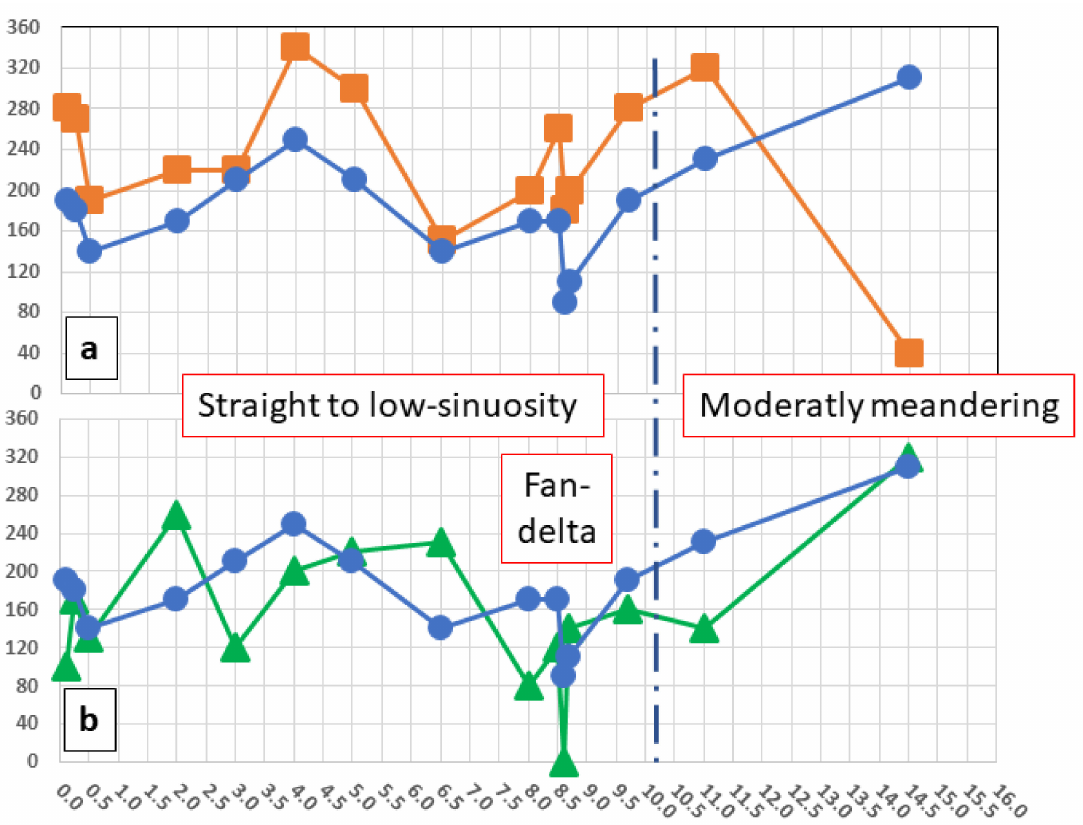
Figure 17. Situmetry (orientation) vs. topography, x-axis denotes in graphs the distance to the source area in km and the sampling sites shown in Figures 3 and 5. The vertical stippled line marks the basement-foreland boundary. Blue graph: Orientation of the talweg in degree ( a ) Brown graph: Orientation of the 1st order maximum in the situgram, ( b ) Green graph: Orientation of the 2nd order maximum in the situgram. The red boxes denote the morphology and landforms of the drainage